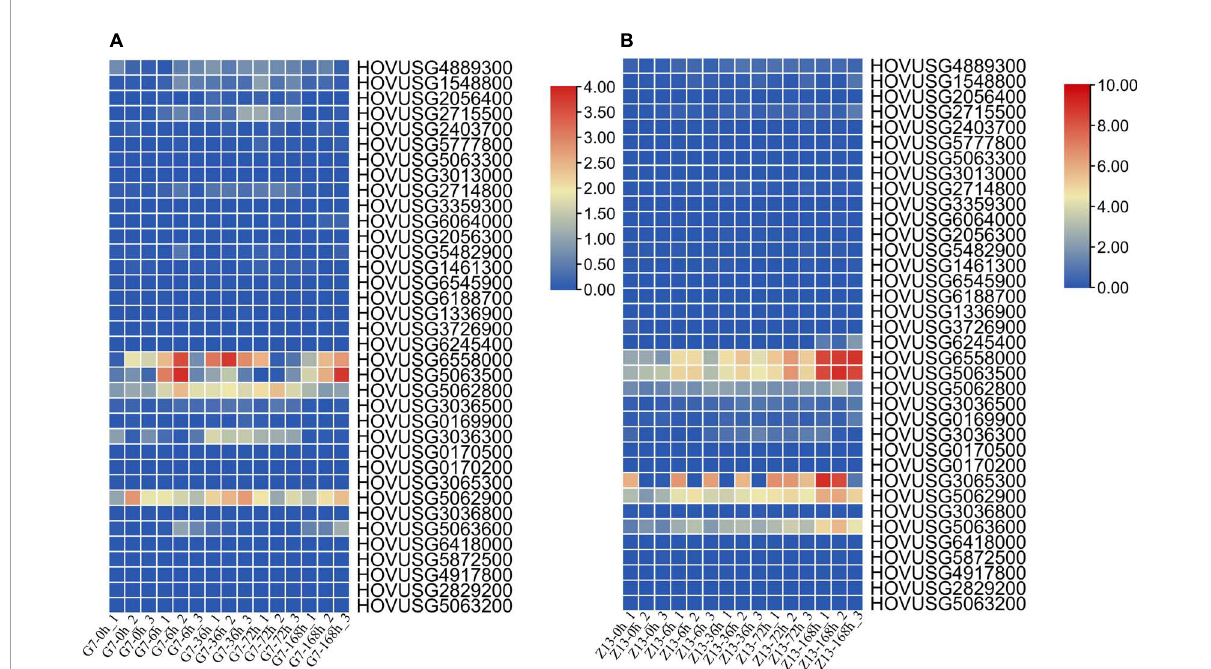
FIGURE6 Expression of Qingke TLP genes in response to powdery mildew infection. Their expression levels at 0, 6, 36, 72, and 168 h post-inoculation (hpi) (A) in the powdery mildew-resistant cultivar Gannongda7 (G7) and (B) the powdery mildew-sensitive cultivar Zangqing13 (Z13). The RNA-seq data was downloaded from SRA database, and aligned to the Qingke genome to calculate the expression levels of TLP genes. Bars are colored according to the log2 (TPM + 1)